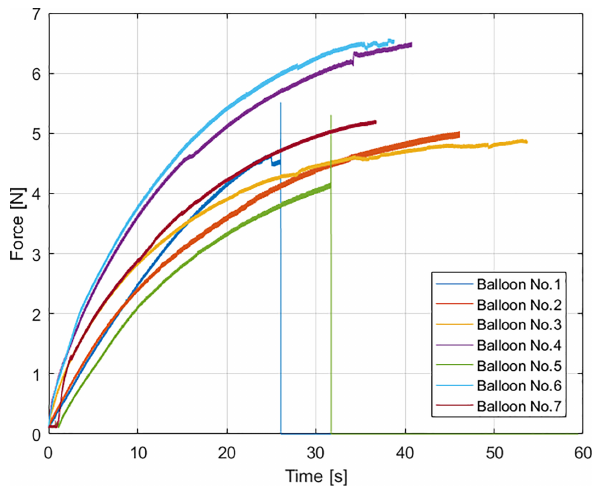
Figure 9. Forces measured at the distal end of seven balloons con- stricted in a one meter long cylindrical tube.